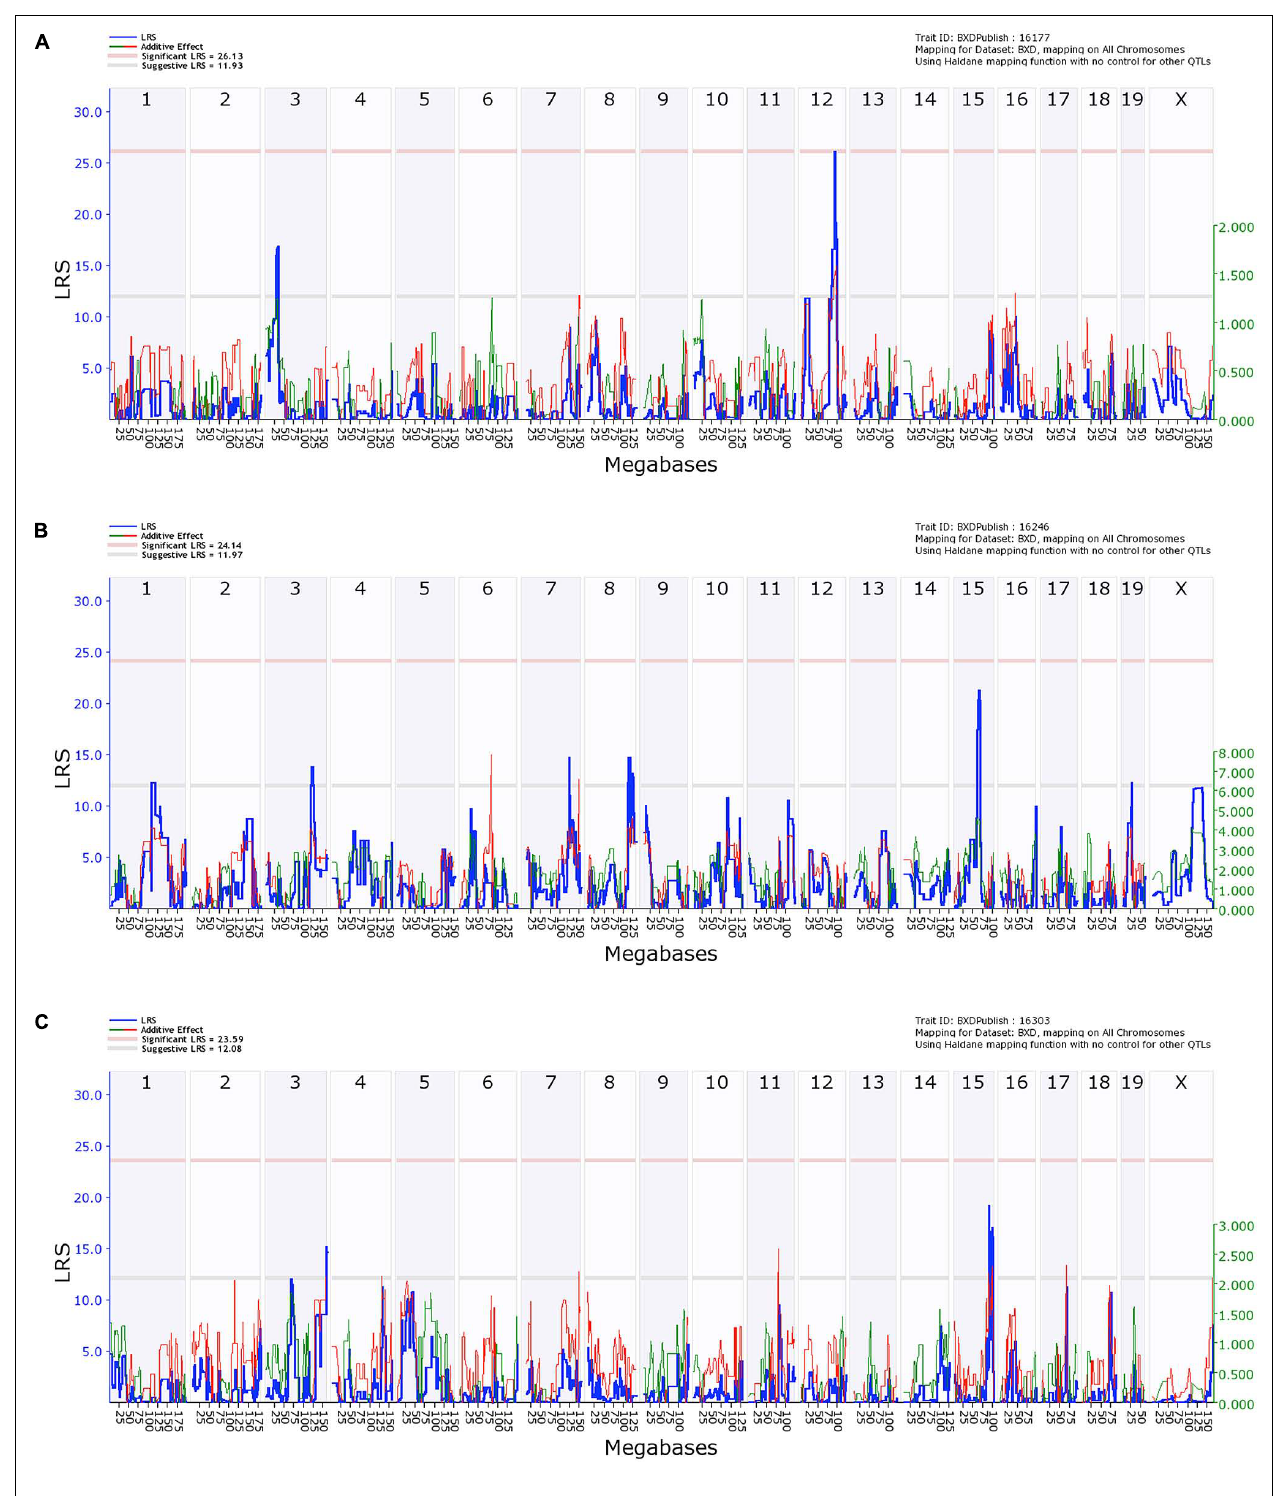
FIGURE 5 | Quantitative trait locus (QTL) analysis of cell death in the Hippocampus and Cortical Layers 2/3 and 5. On the X-axis are the chromosomes from 1 to 19 and the X. On theY-axis are the LRS scores.The region bounded by the gray and red horizontal lines are suggestive QTLs